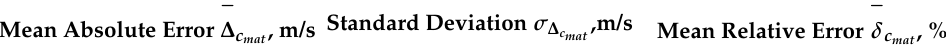
Table 1. The metrological characteristics of the phase-velocity ( v = 1590 m/s) dispersion curve for the A 0 mode.